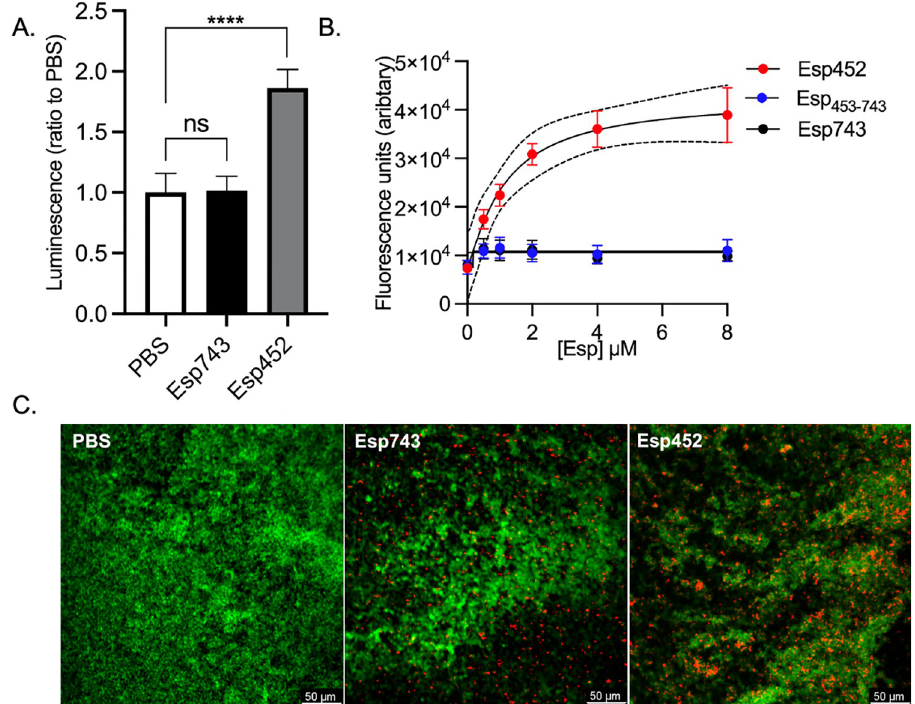
Fig 4. Esp452 inhibited within intact N-terminal region. A. Luminescence of biofilm fractions of MMH594b ( Δ esp ) biofilms grown with PBS, Esp743, or Esp452, divided by the average luminescence of biofilm fractions from biofilms grown with PBS. The experiment was conducted with triplicates in three independent experiments. The SEM is indicated with error bars. Samples were compared by Welch’s ANOVA and D3 Dunnett’s post hoc test. ���� p < 0.0001. B. Fluorescence of Thioflavin T added to MMH594b ( Δ esp ) biofilms that were grown with Esp452, Esp 453- 743 , or Esp743. Fluorescence measurements from three independent experiments were combined. The SEM is indicated with error bars. The 95% CI for the dose-response curve of Esp452 is shown as dashed lines. C. Confocal microscopy images of MMH594b ( Δ esp ) biofilms grown with PBS, Esp743-AF647, or Esp452-AF647 (red). Biofilms were stained with Syto-13 (green). The images represent Z-stacks with the greatest number of red pixels.